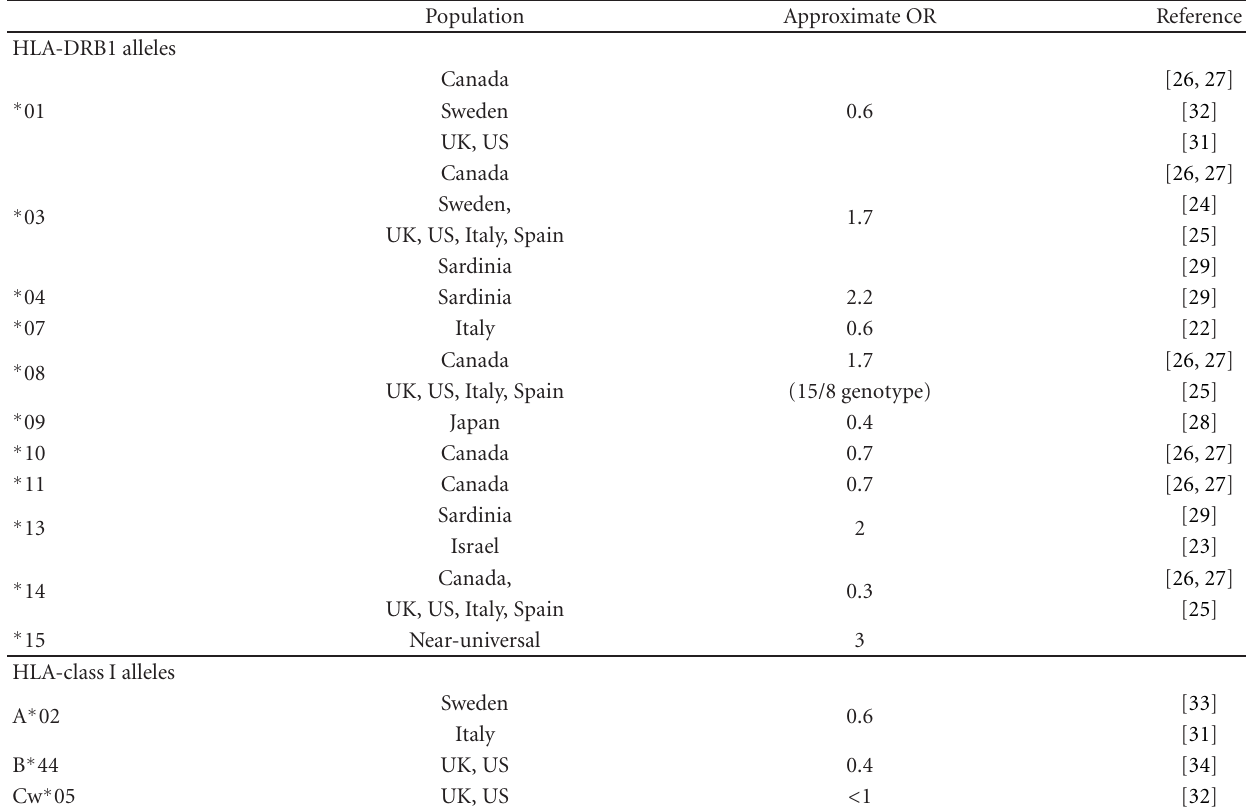
Table 2: Reported HLA class II and class I associations across the